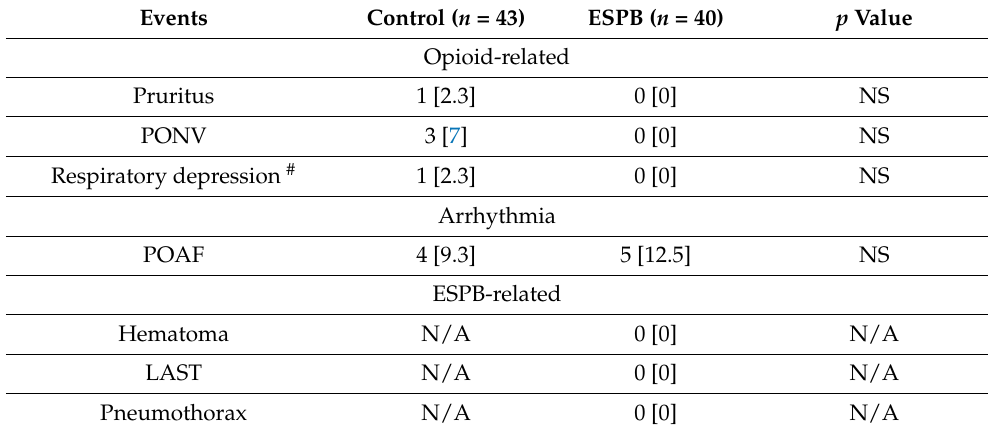
Table 3. Intergroup comparison for adverse